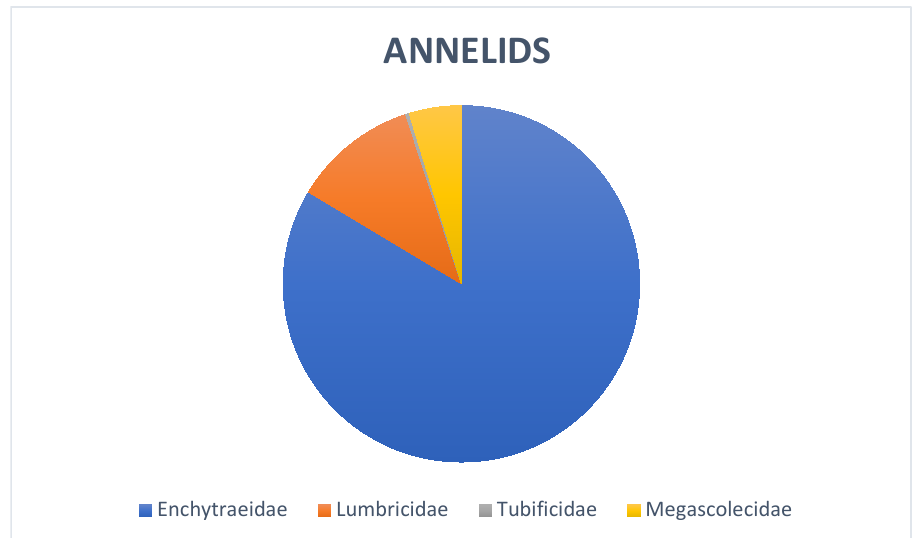
Figure 3. Representation of Annelida community composition detected with eDNA metabarcoding.